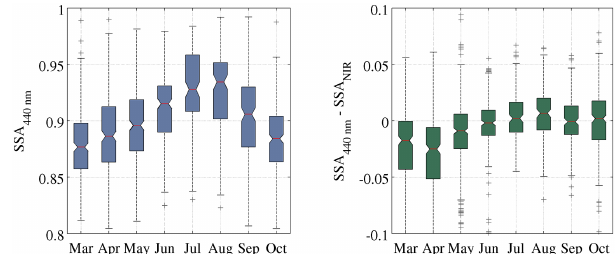
Figure 2. Monthly variation of the SSA at 440nm (left) and the dif- ference between SSA at 440nm and average of near-infrared chan- nels (NIR, 670, 870, and 1020nm) (right) at the Beijing AERONET station. The red central marks in each box indicate the median val- ues while the upper and lower edges of the boxes indicate 75th and 25th percentiles. The whiskers are showing extreme values and the outliers are marked with